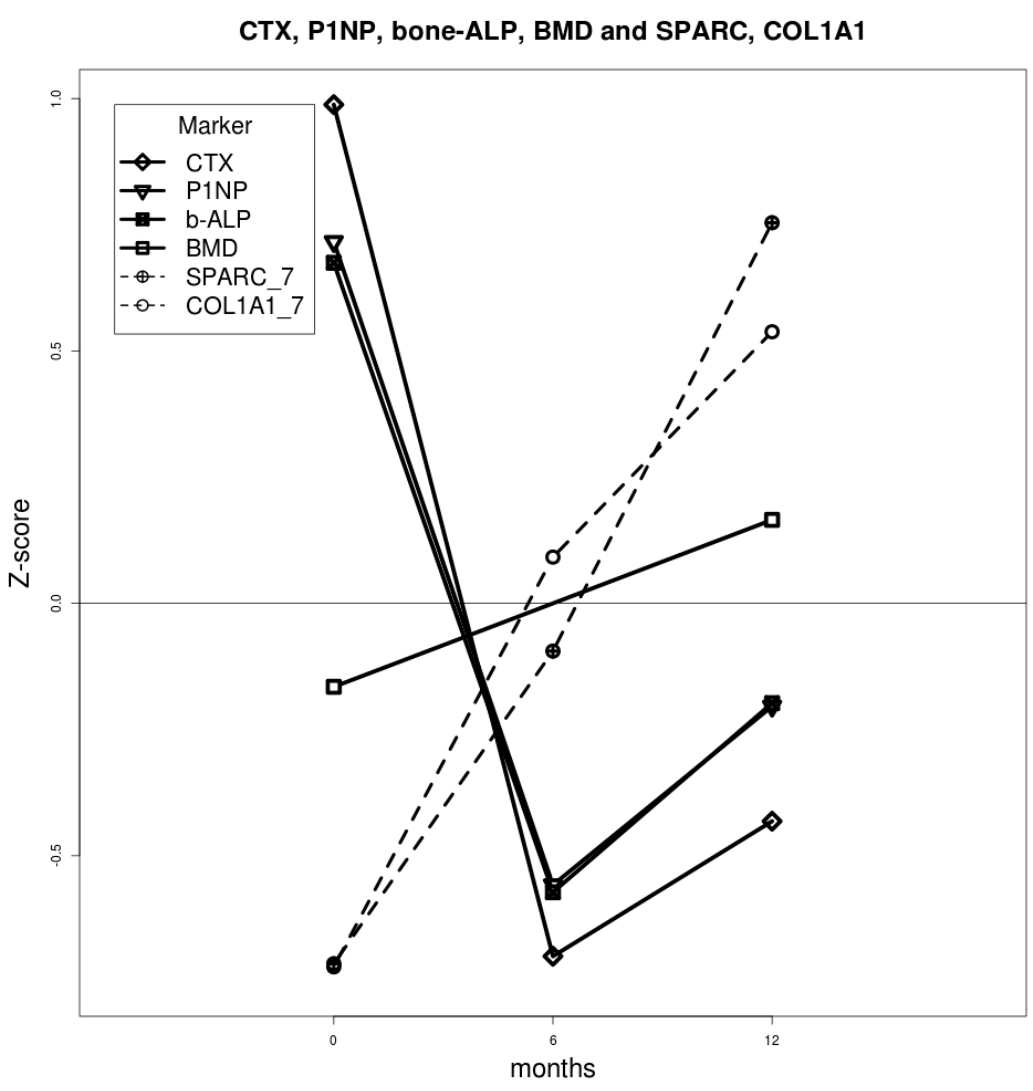
Figure 2. Mean values of bone metabolism/osteogenic differentiation markers across the time points. Biochemical values were obtained from blood samples; qRT-PCR values obtained from differentiating cells were utilized as gene expression markers. For each marker, mean values were calculated from the standardized z-score. The lumbar BMD increase during treatment correlated significantly with the expression of osteogenic marker SPARC ( p < 0.05); COL1A1 gene expression showed an analogous trend without reaching any statistical significance ( p > 0.05).